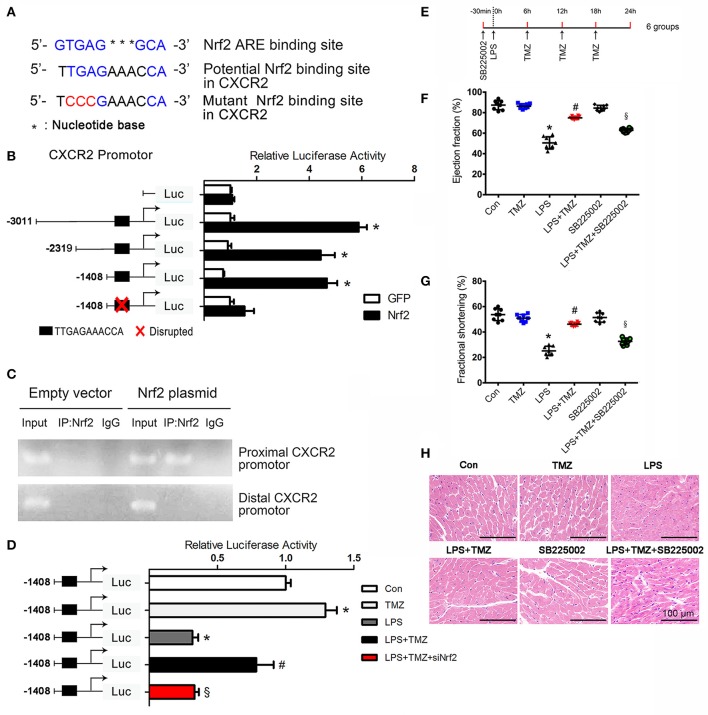
CXCR2 is transcriptionally regulated by TMZ via Nrf2 in LPS-induced cardiac dysfunction. (A) Nrf2 ARE consensus binding site, potential Nrf2 binding site and the mutant Nrf2 binding site relative to potential Nrf2 binding site on mouse CXCR2. Blue indicates binding site, red indicates mutated base. (B) Luciferase activity of the constructs transfected into HEK293T cells. The first base before ATG represents−1. (C) Nrf2 chromatin immunoprecipitation. HEK293T cells were transfected with an empty plasmid or plasmid expressing Nrf2. PCR assays on input and IP fractions amplified the CXCR2 promoter containing the putative Nrf2 site (−919/−909, top panel) or a distal region of the Nrf2 promoter (−2727/−2717, bottom panel). (D)−1408/+254 CXCR2 promoter constructs and si-Nrf2 were transfected into HEK293T cells, and then subjected to TMZ (20 μM), LPS (5 μg/ml) or combination stimulations. Relative luciferase activity of−1408/+254 CXCR2 promoter construct after stimulations. (E) Schematic drawing of experimental schedule for the mice study. 8–10 week-old C57BL/6 male mice were first intraperitoneally injected with the CXCR2 inhibitor SB225002 (10 mg/kg) and LPS (15 mg/kg), then TMZ was administrated by gavage every 6 h for 3 times after LPS injection for 6 h. (F,G) Ejection fraction and fractional shortening was measured by two-dimensional echocardiography. (H) Representative images of left ventricular myocardium H&E staining. Scale bars: 100 μm. Data is presented as mean ± SEM in vivo and mean ± SD in vitro of three independent experiments. *P < 0.05 vs. corresponding Control group or GFP control; #P < 0.05 vs. LPS group; §P < 0.05 vs. LPS+TMZ group. n = 8 mice per group.